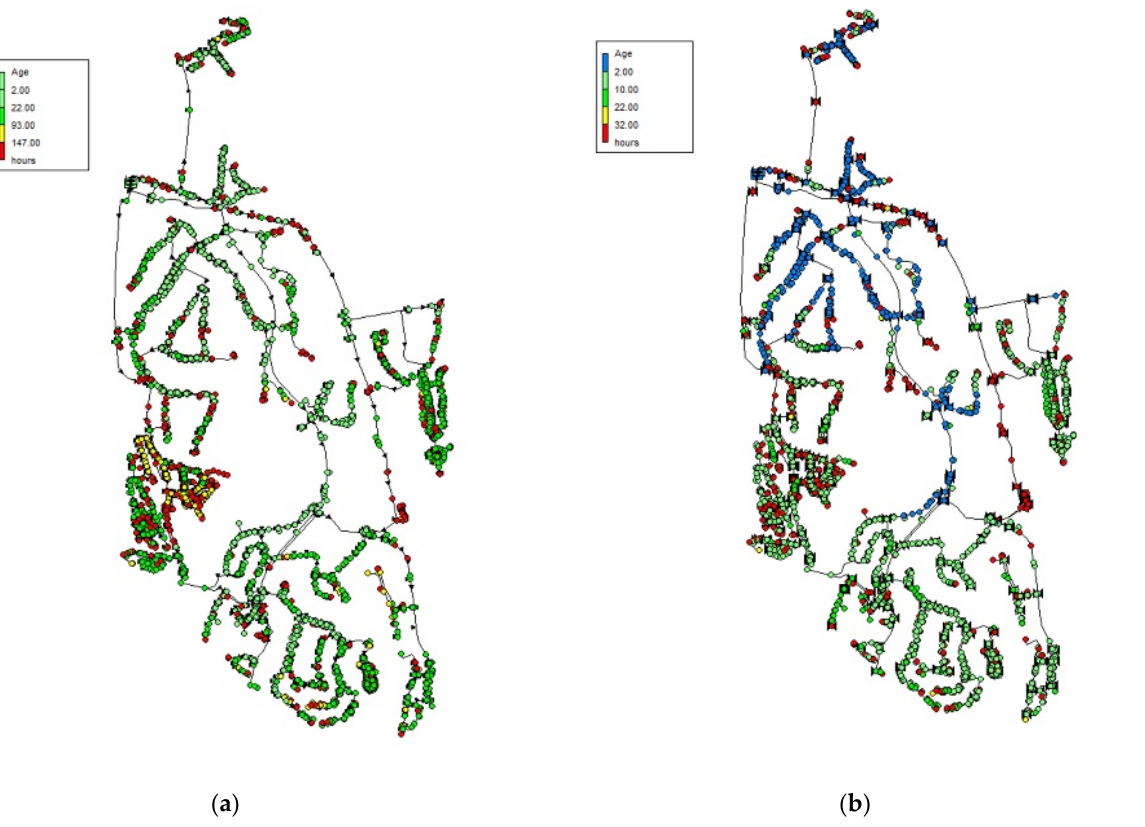
Figure 10. Water age distribution over the network in Case Study 2 ( a ) in winter and ( b ) in summer.